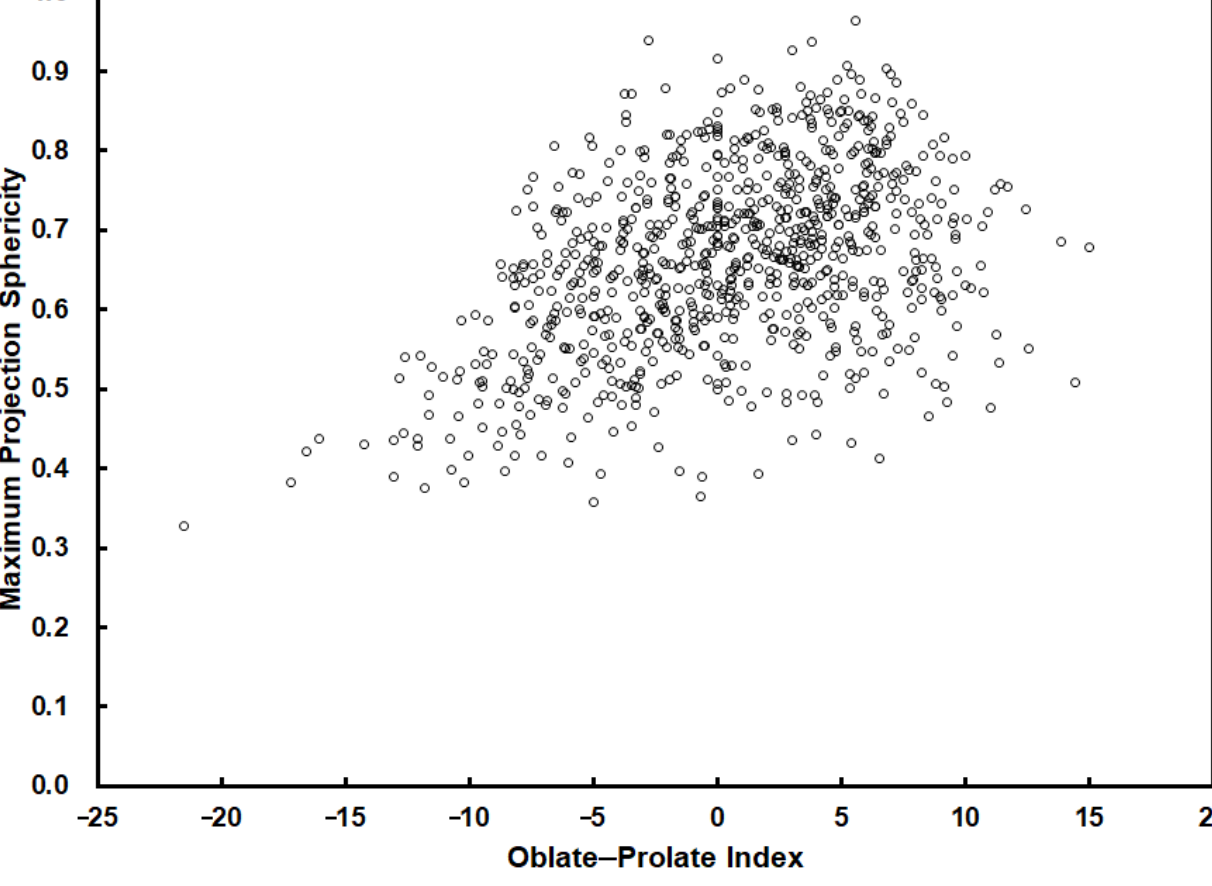
Figure 14. The Oblate–Prolate Index and Maximum Projection Sphericity of fluvial gravels of Navilawa Monzonite from Stations 1–7 along the Sabeto River of western Viti Levu, Fiji.